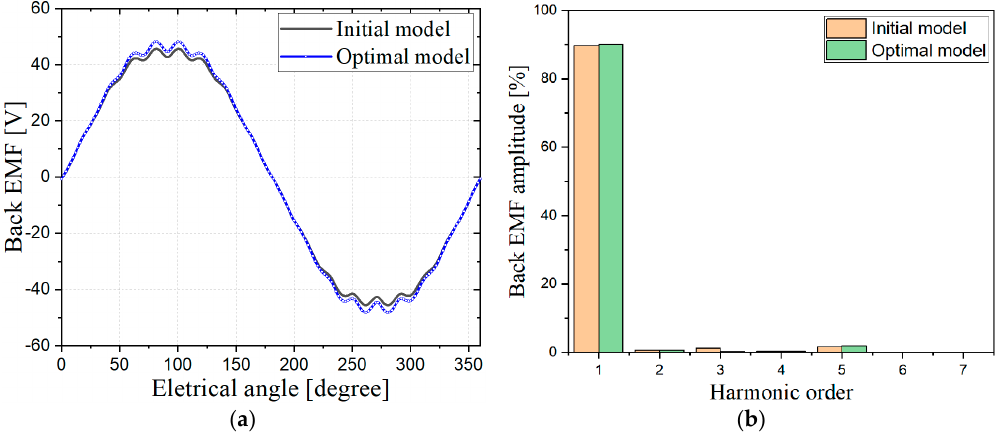
Figure 11. The back EMF of the initial model and optimal model: ( a ) waveform; ( b ) harmonic.